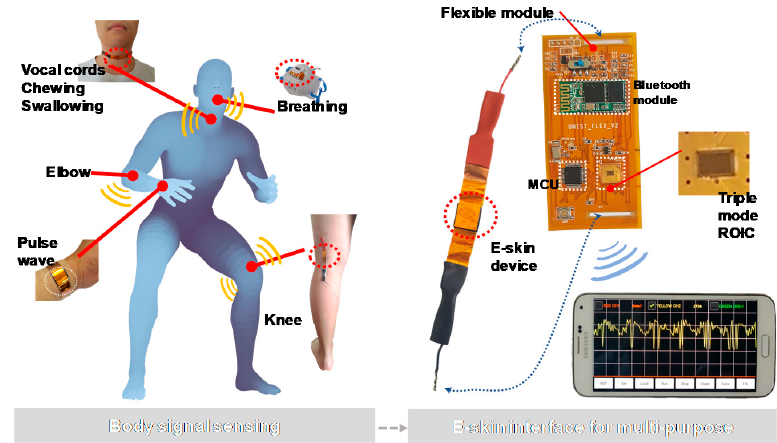
Figure 1. A triple-mode flexible e-skin sensor interface.